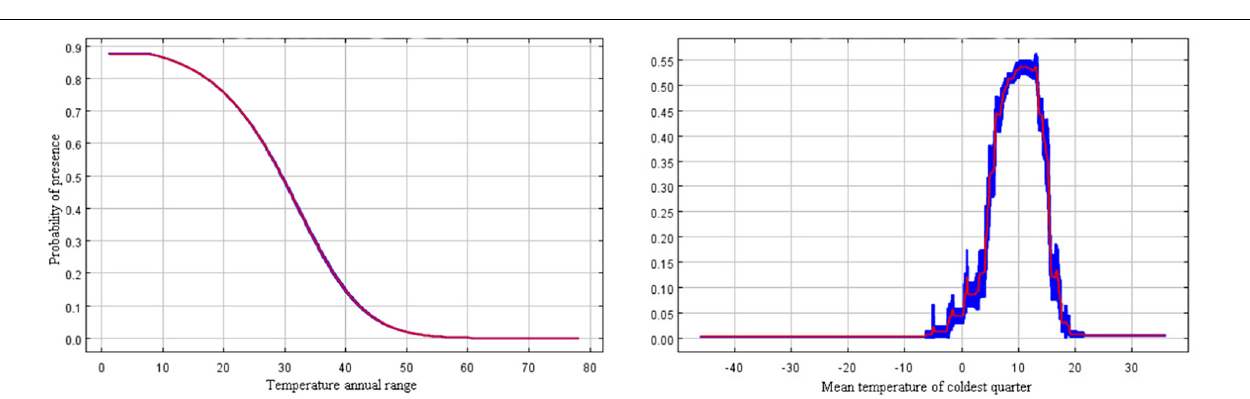
FIGURE 3 | Regularized training gains of environmental variables using the Jackknife method in MaxEnt based on the native and invasive distribution records of Rapistrum rugosum.